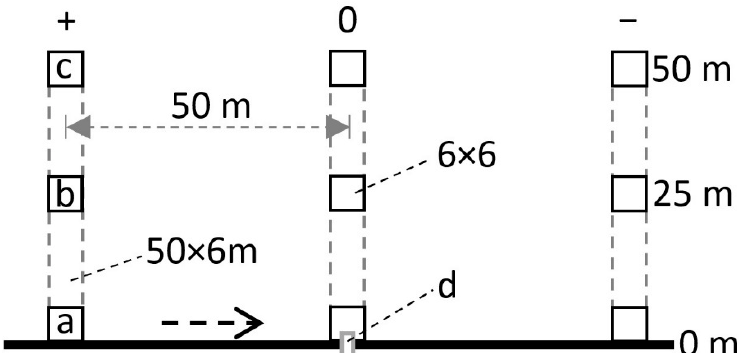
Figure 2. Sampling scheme for assessing beaver foraging and floristic characteristics of sample plots.